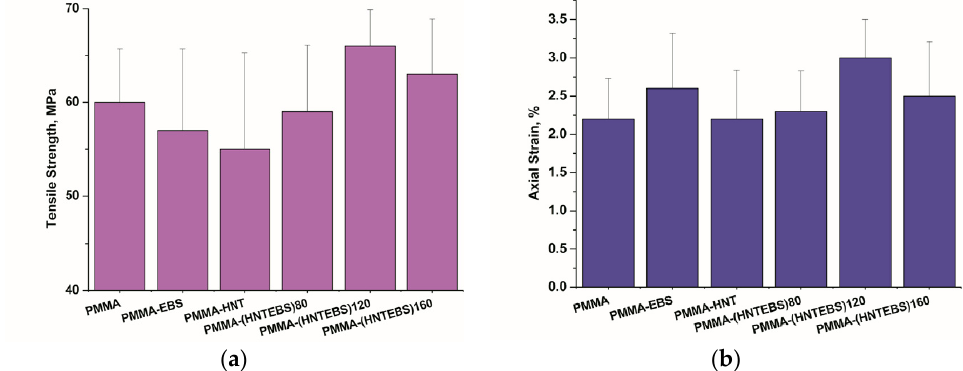
Figure 13. Tensile strength ( a ) and axial strain ( b ) of PMMA/HNT nanocomposites compared to PMMA and PMMA with EBS or HNT.